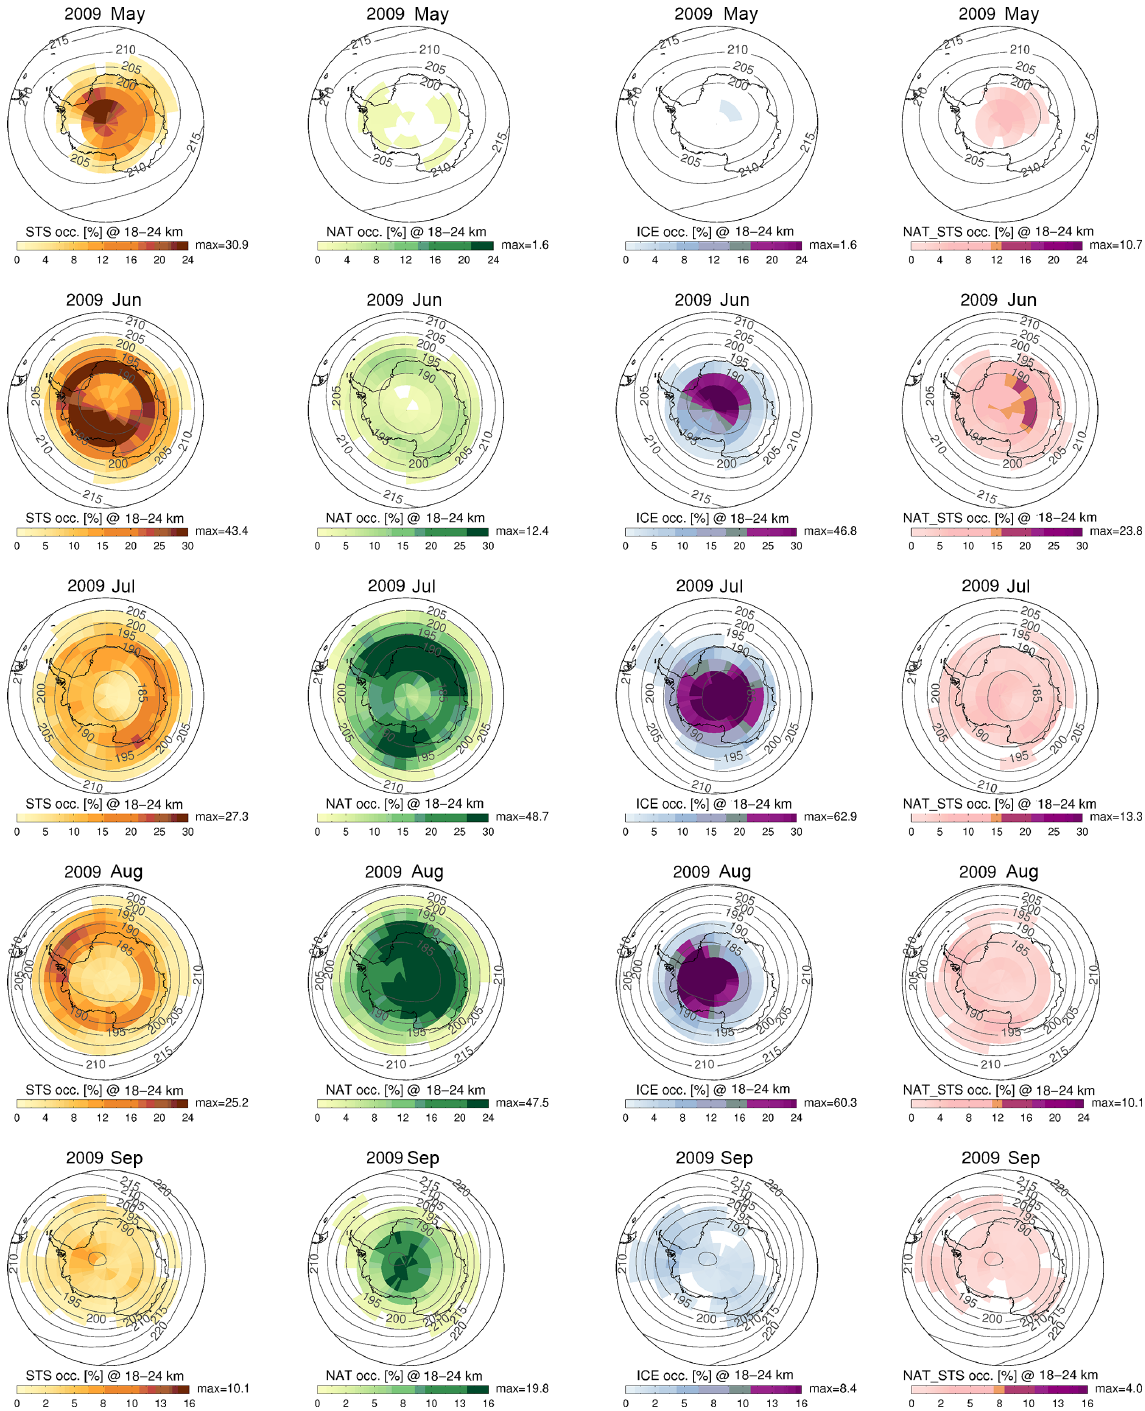
Figure 9. Monthly polar MIPAS PSC type occurrences between 18 and 24km for the southern polar winter conditions. Each row shows 1 month (May to September) for 2009 and the respective four main classes STS (orange), NAT (green), ice (blue), and mixed-type class NAT_STS (purple colour code) for the Bayesian classifier. Please note the partly different scaling of the colour code for each month and type. In addition, monthly mean ERAi-based temperature contours at 50hPa are